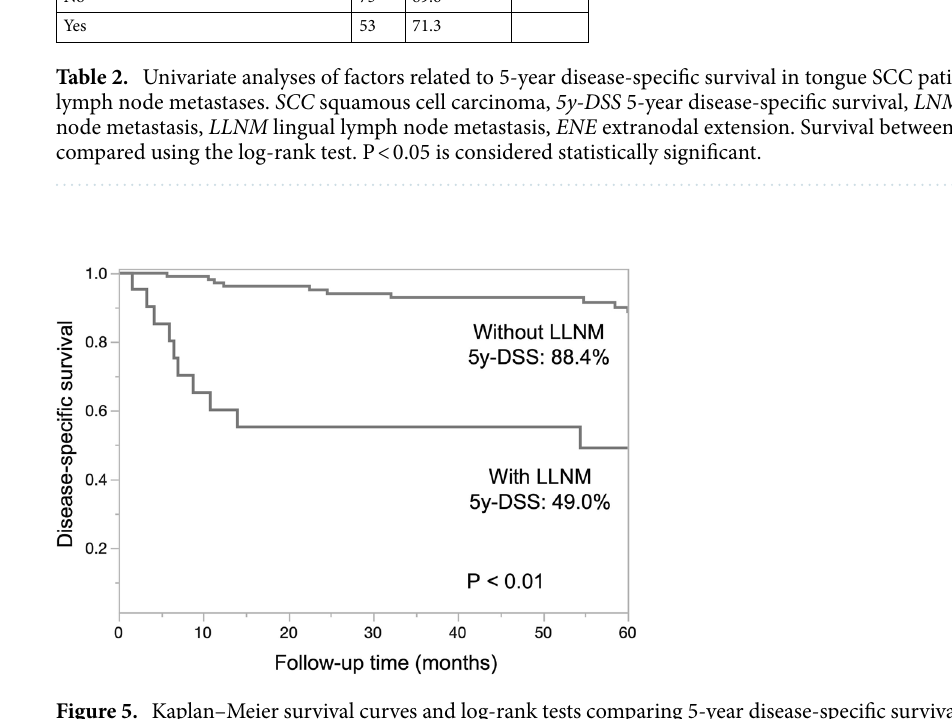
Figure 5. Kaplan–Meier survival curves and log-rank tests comparing 5-year disease-specific survival (5y-DSS) in patients with lingual lymph node metastases (LLNM) and patients without